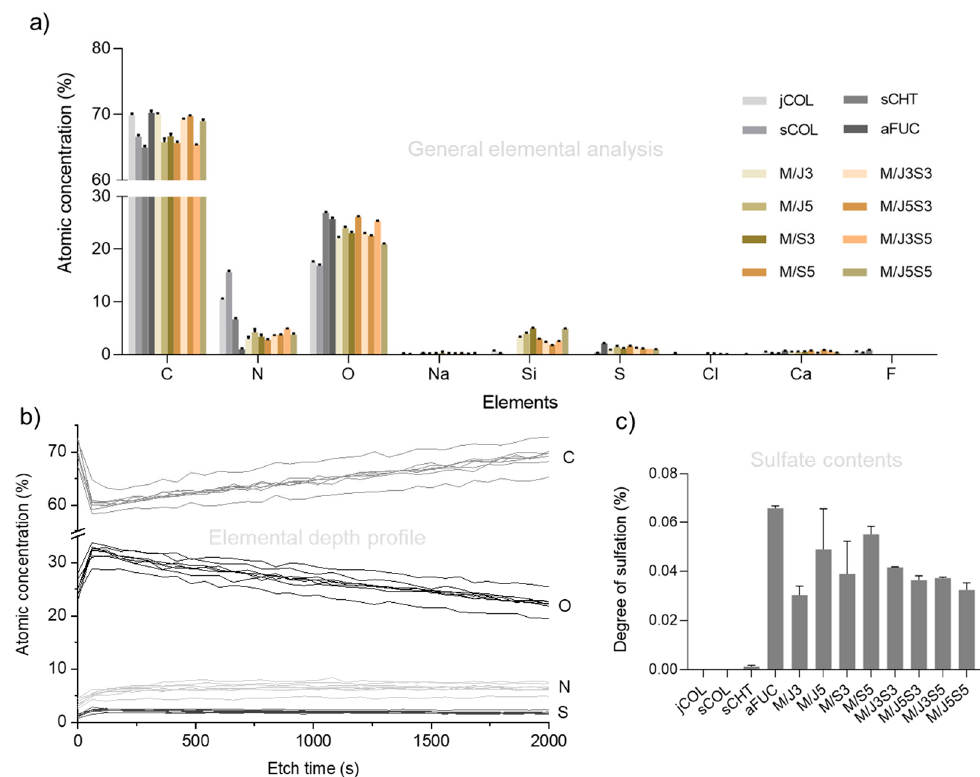
Figure 4. XPS analysis on the marine biopolymers and the developed membranes. ( a ) Atomic concentration (%) of main elements at the surface of the material; ( b ) atomic concentration (%) of main elements from in-depth pro fi le assay as a function of etch time; and ( c ) determination of the sulfate contents (%) in all samples. Table 1. Average and standard deviation of the atomic concentration ratios between sulfur/carbon, sulfur/nitrogen and nitrogen/carbon on the surface of each biopolymers studied and on the devel- oped biomaterials.